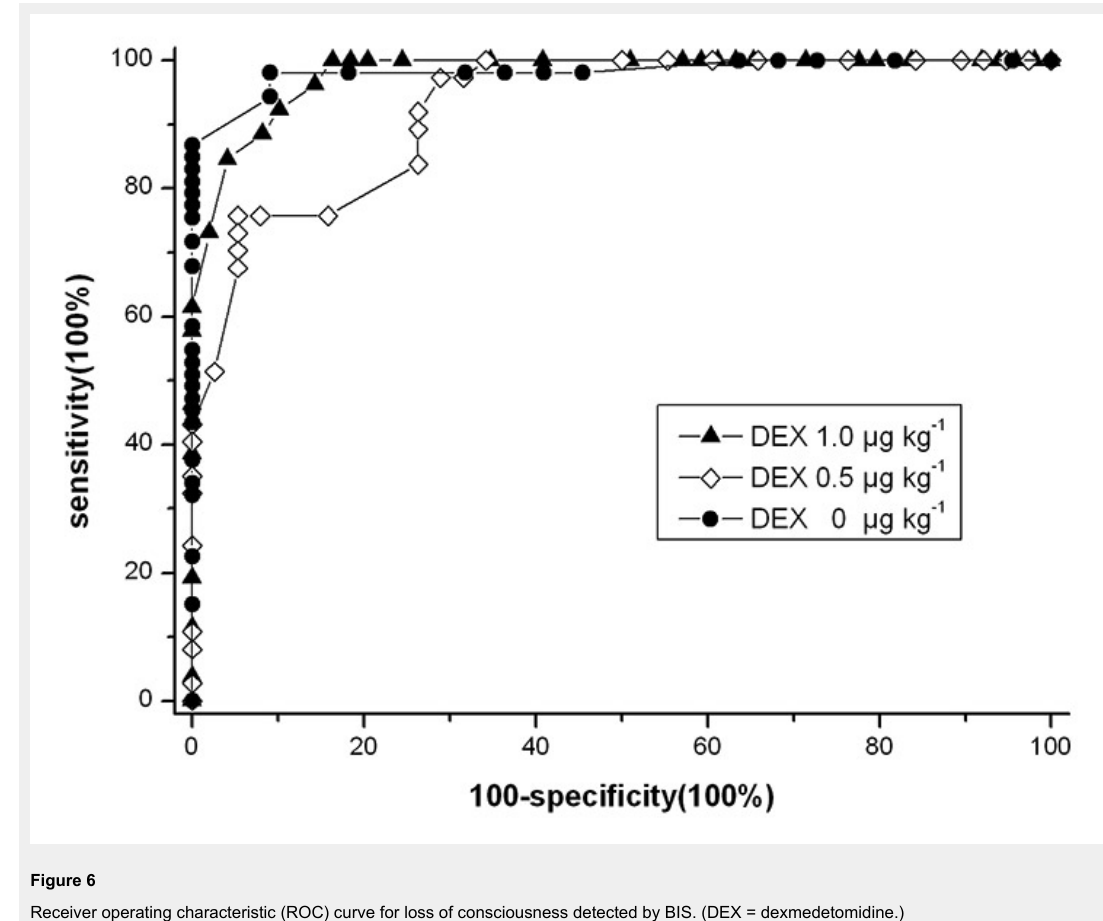
Figure 6 Receiver operating characteristic (ROC) curve for loss of consciousness detected by BIS. (DEX =